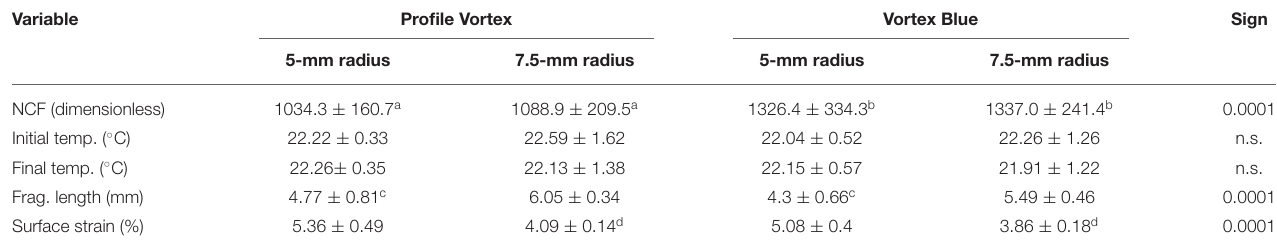
TABLE 1 | Parametric statistics comparing experiments with the two rotaries and the two different fixtures. Variable